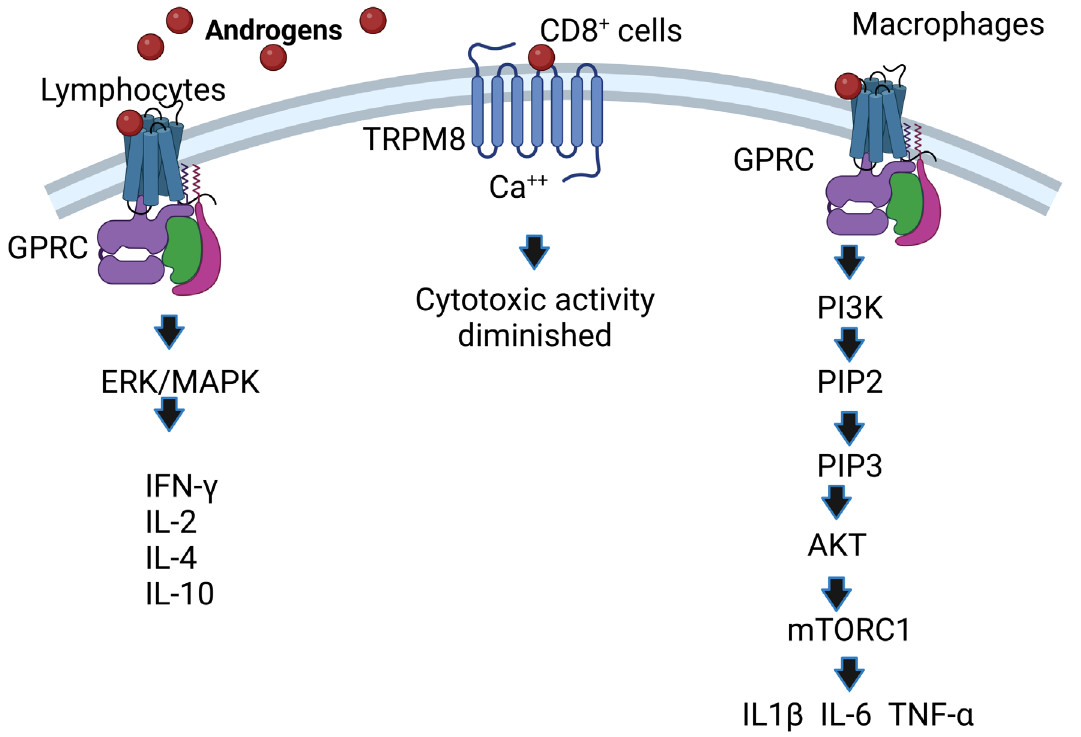
Figure 3. AR-independent effects of androgens. Androgens bind to membrane receptors that trigger the activation of the ERK (MAPK) pathway in lymphocytes, and IFN- γ , IL-2, IL-4 and IL-10 expression is increased. Likewise, androgens activate the phosphatidylinositol-3 kinase (PI3K) pathway; if this pathway is activated in macrophages, it regulates the expression of the cytokines IL1 β , IL-6 and TNF- α . Image created based on the concepts described in [43] using the BioRender.com software. The interaction of androgens with TRPM8 causes Ca ++ to increase, which decreases the activity of cytotoxic T cells.